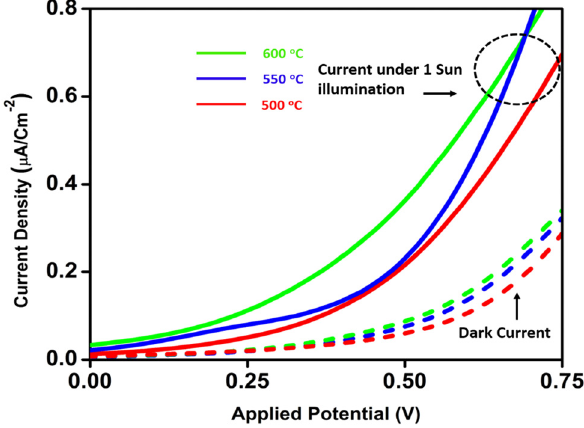
Figure 6: LSV outcomes of Tl 2 S thin fi lms deposited on the FTO substrate using three di ff erent temperatures via the AACVD